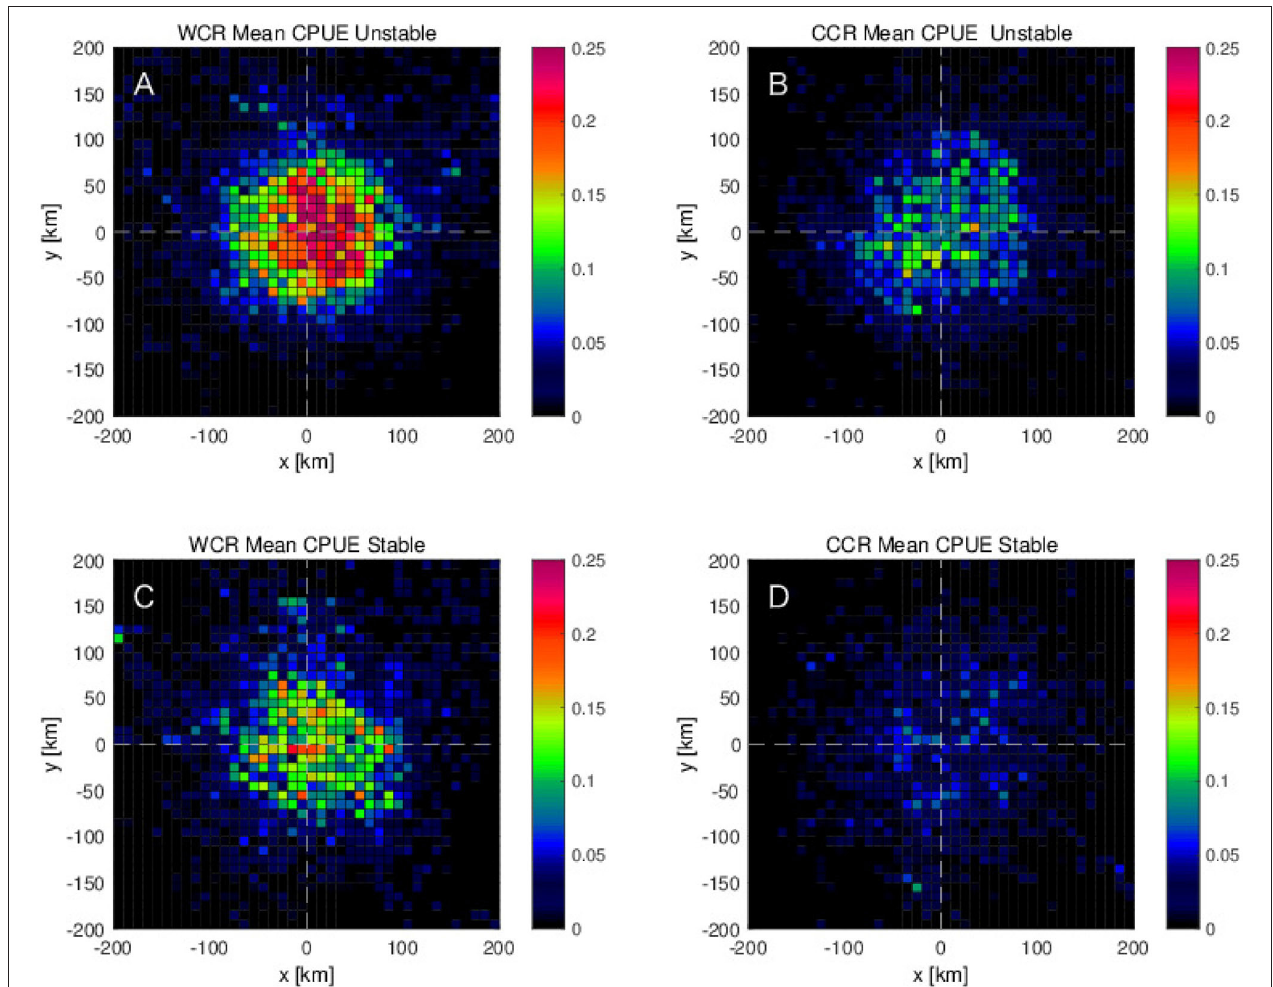
FIGURE 9 | Mean CPUE as a function of distances from the center of eddies along zonal and meridional directions for (A,C) anticyclonic eddies (or warm-core rings: WCR) and (B,D) cyclonic eddies (or cold-core rings: CCR), which are closest to each swordfish fishing position in (A,B) unstable period 2006–2009 and in (C,D) stable period for years 2004, 2005, and